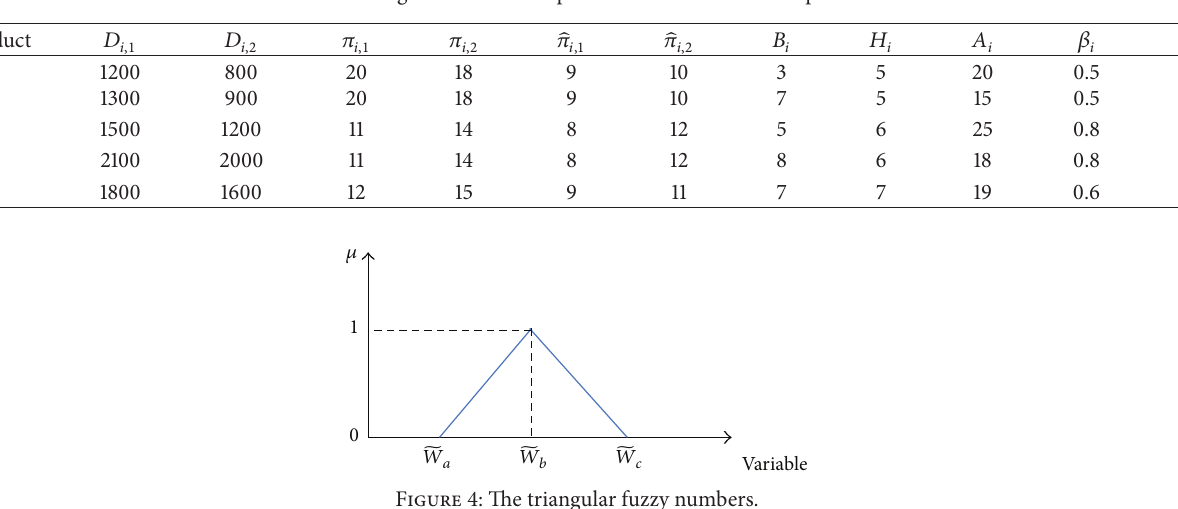
Table 3: The general data for a problem with 5 items and 3 periods.